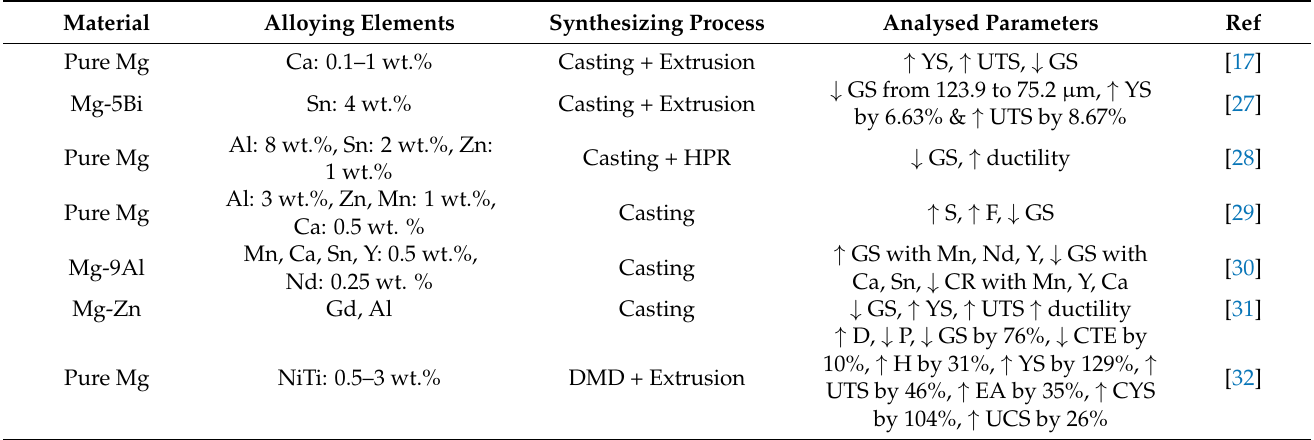
Table 1. Summary of literature reviews of magnesium alloys and their